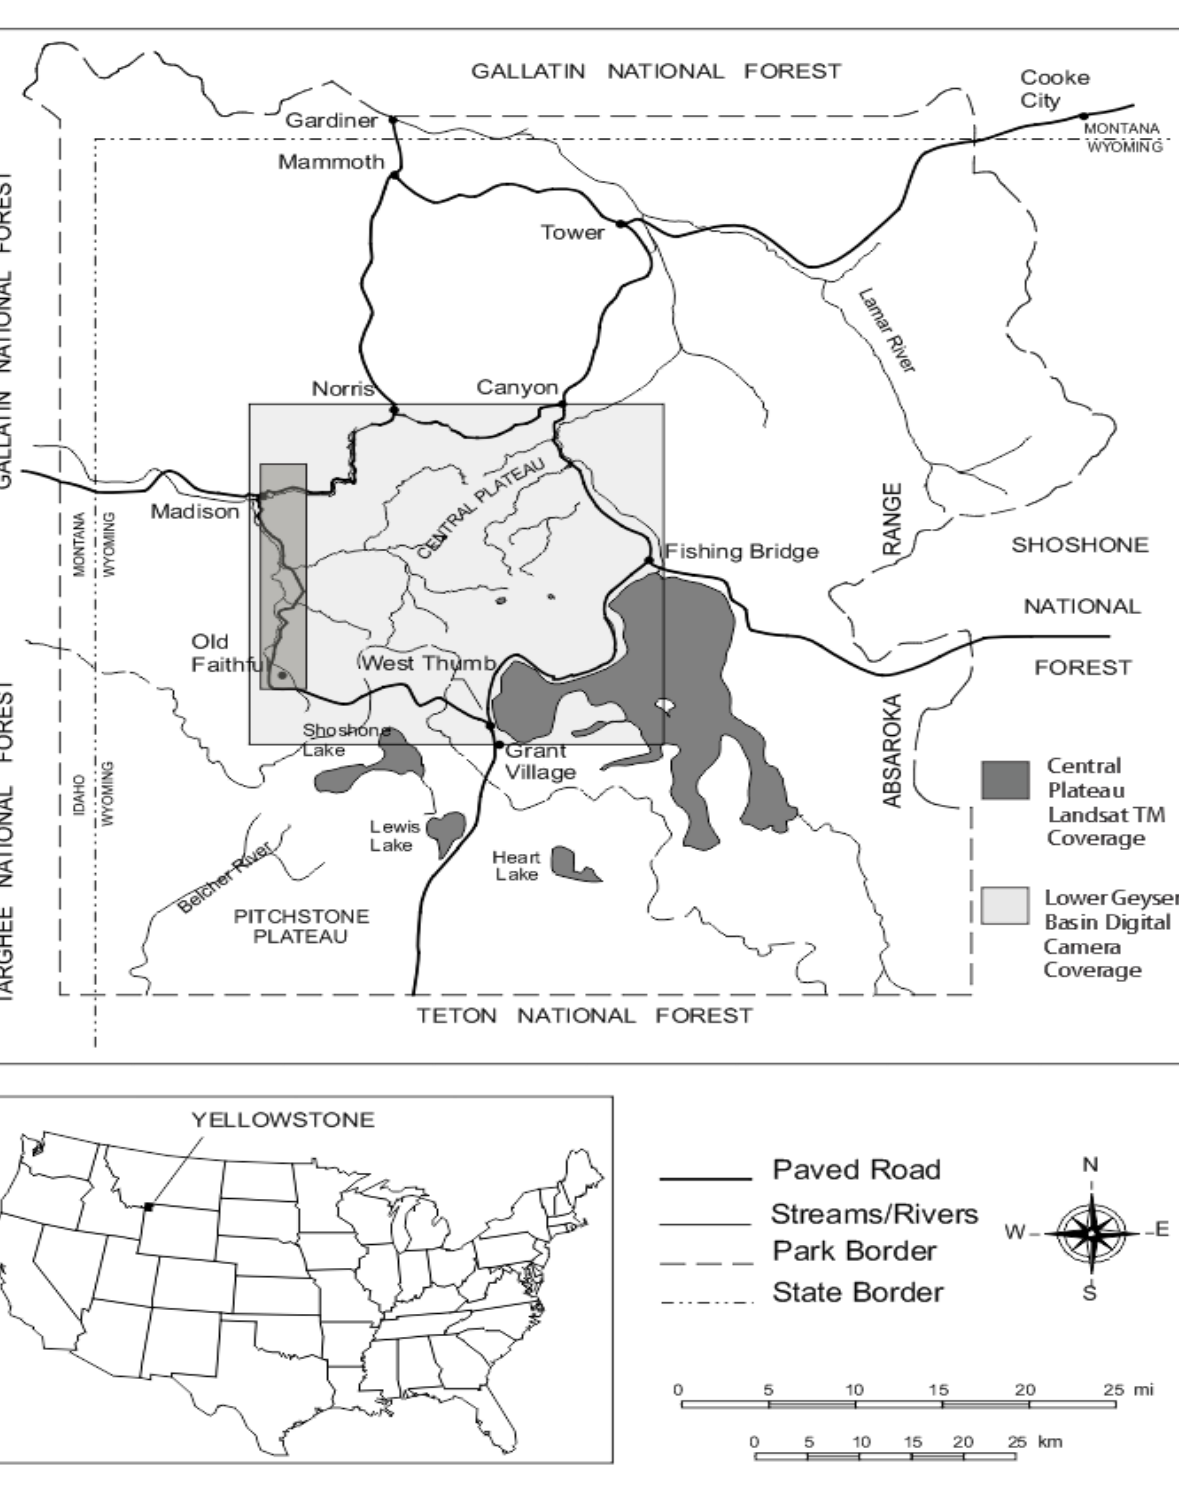
Figure 1. Study area, a footprint of a Landsat TM scene is show for